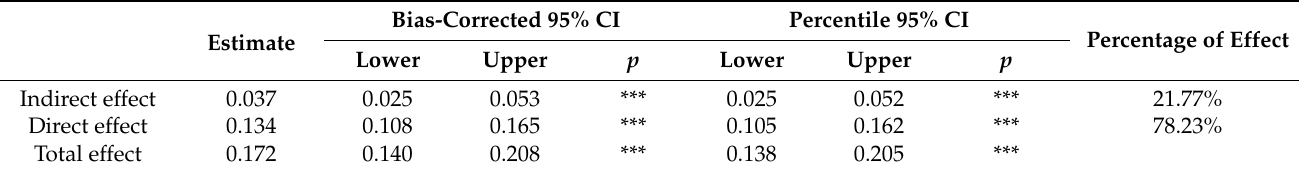
Table 2. Mediating effect and 95% confidence interval estimated by the bootstrap